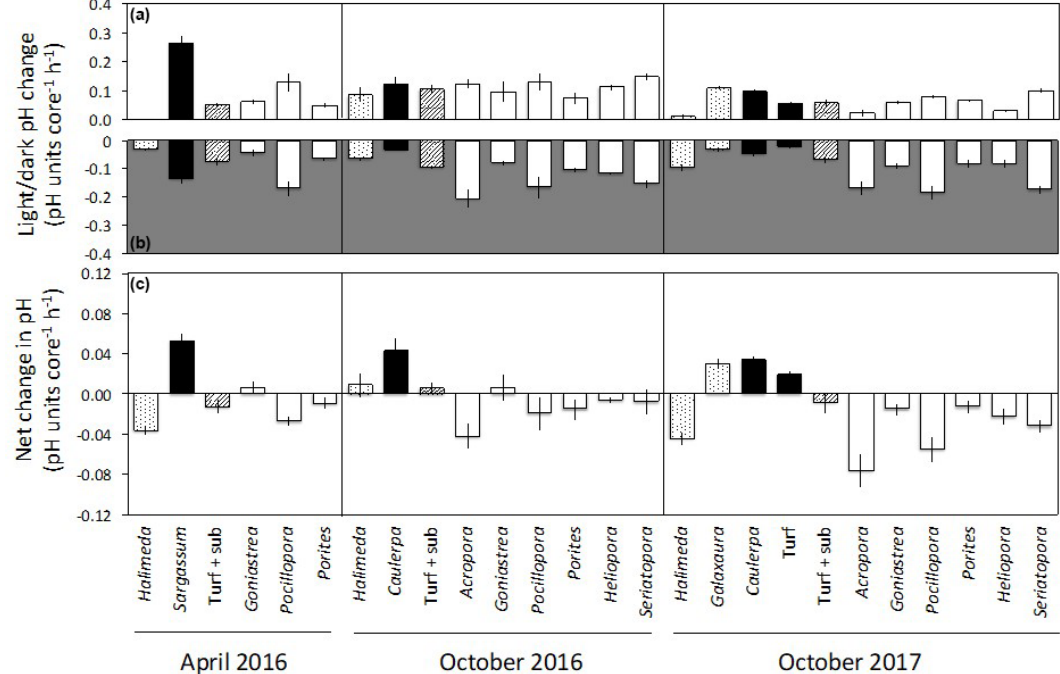
Figure 4. Net changes in pH per hour for each 1.56L incubation core (mean ± SE) in light (a) and dark (b) incubations of calcifying algae (stippled), macroalgae and turf (black), turf + substrate (diagonal stripes) and coral (white). Panel (c) shows the net change in pH per hour (mean ± SE), assuming equal periods of light and